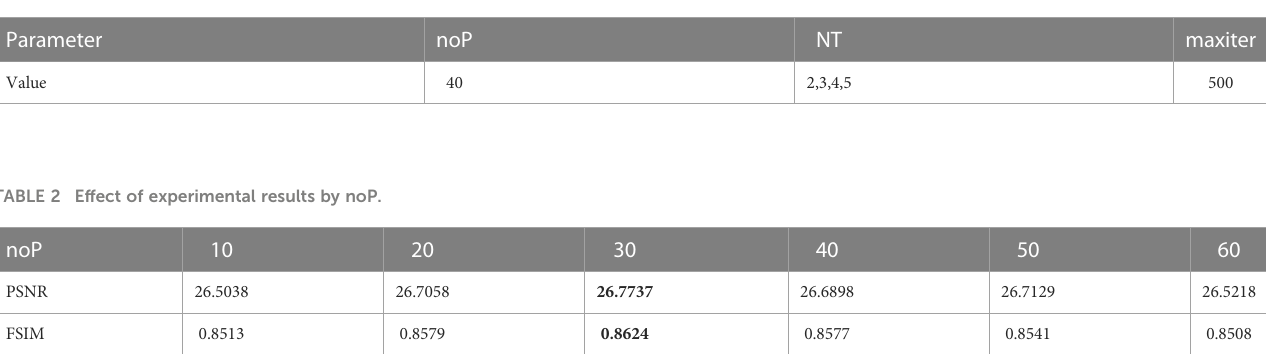
TABLE 1 Experimental related parameter setting.